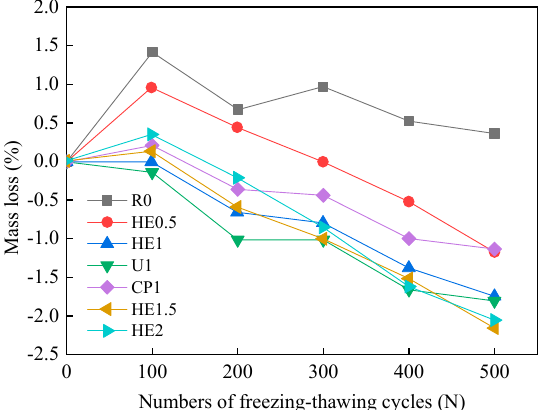
Figure 7. Mass loss of CGAC with different types and content of steel fiber.